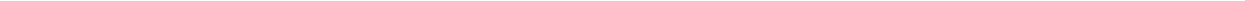
Fig. 6 Anti-CSF1R-treatment or CSF1-stimulation do not directly affect crypt homeostasis. a RT – qPCR analysis shows enteroids prepared from the